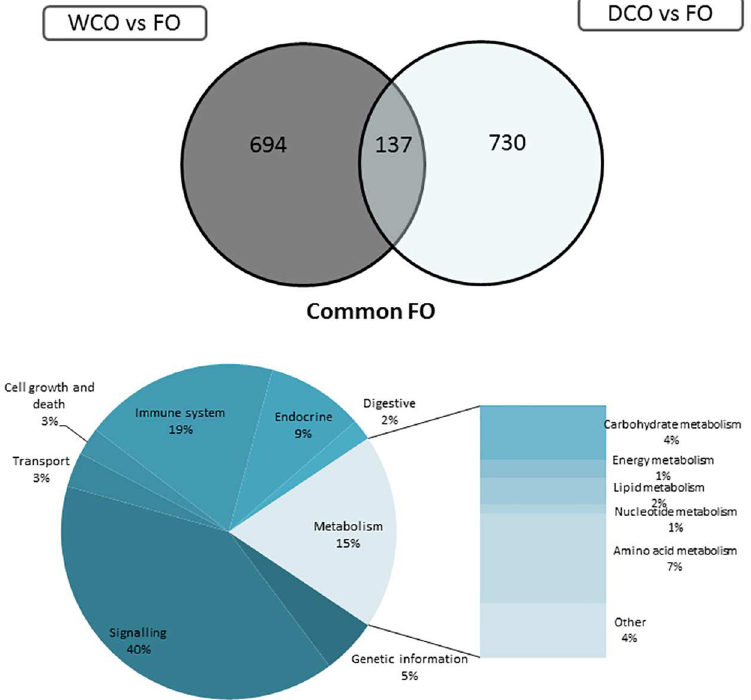
Fig 4. Impact of diet on hindgut transcriptome of Atlantic salmon fed diets containing camelina oils (WCO and DCO) in comparison with fish fed Fish Oil (FO). (A) Venn diagram representing mRNA transcripts differentially expressedin the hindgut of Atlantic salmon fed diets WCO and DCO compared to diet FO. The area of the circles is scaled to the number of transcripts (Welch t-test; p < 0.05; FC > 1.3). (B) Distributionby categoriesof common differentiallygenes in hindgutbetweenAtlantic salmon fed WCO and DCO when comparedto FO-fed fish (Welch t-test; p < 0.05; FC > 1.3). Non-annotated genes and features corresponding to the same gene are not